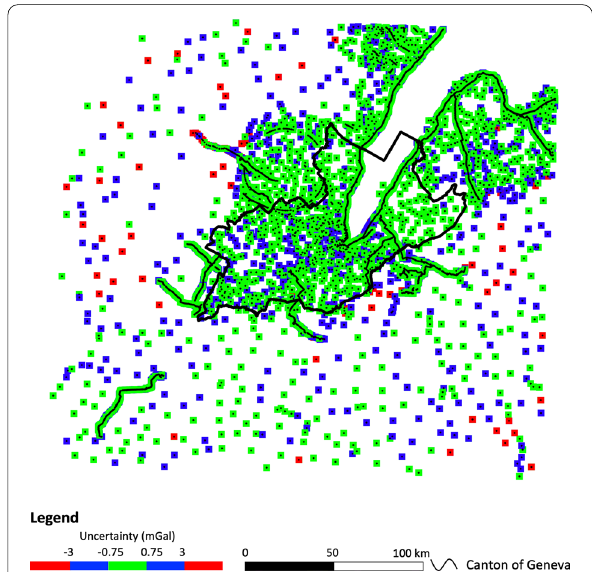
Fig. 4 Map of the uncertainty resulting from summed uncertainties due to elevation and gridding on the gravity data analysed in this study